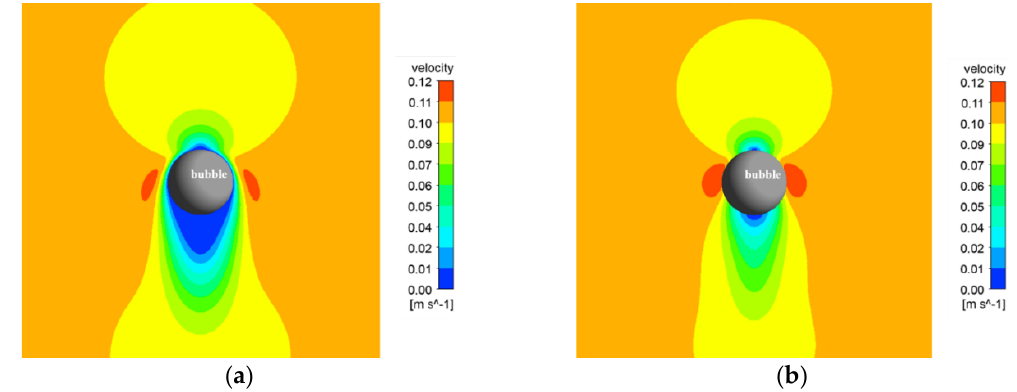
Figure 5. Water velocity contour at bubble diameter = 0.9 mm ( a ) immobile surface bubble; ( b ) mobile surface bubble).